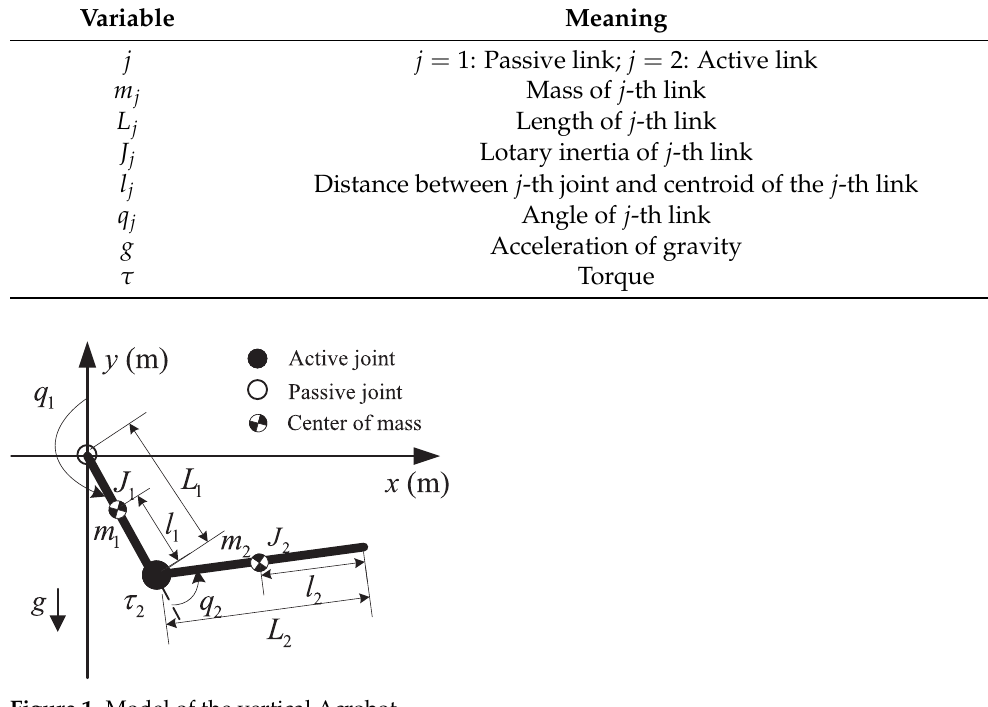
Figure 1. Model of the vertical